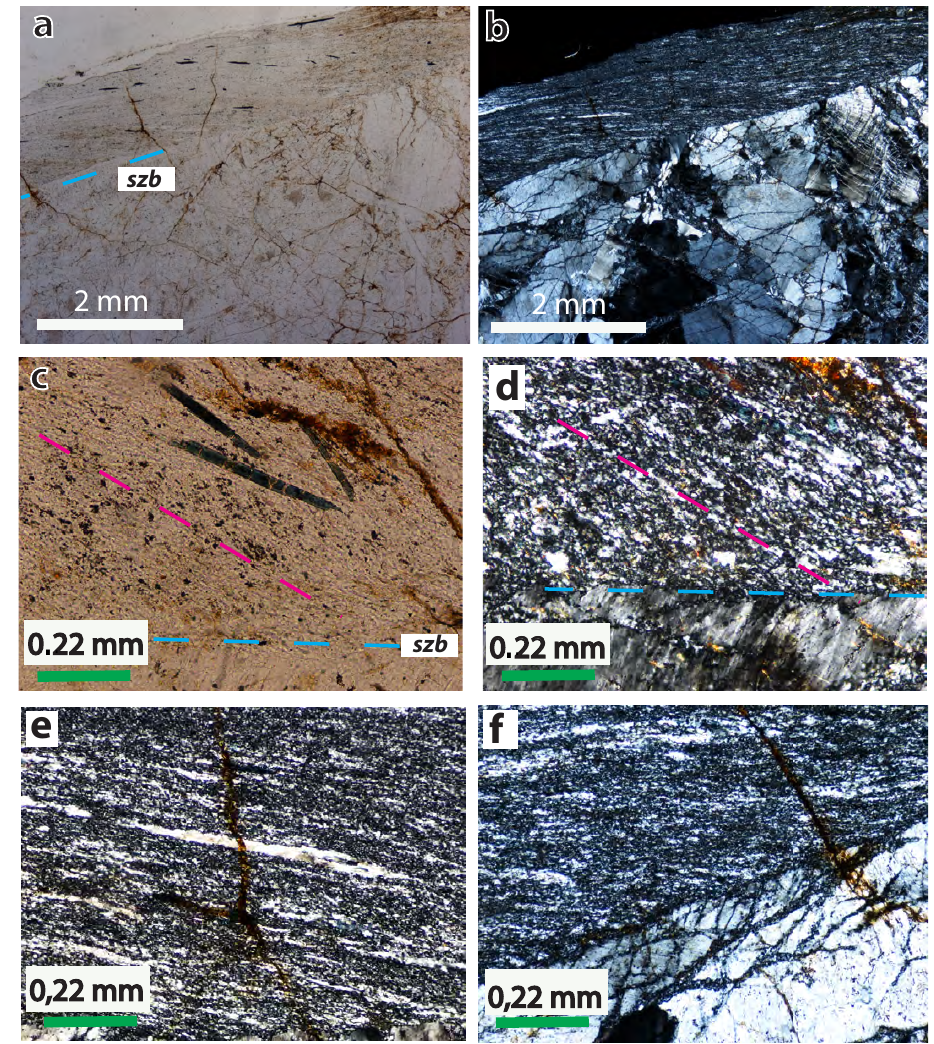
Figure 7. Microscopic view of ultramylonite. (a, b) Detail of ultramylonite and host protomylonite with the sharp shear zone boundary (szb) heritage of former host-fracture contact: (c) synkinematic Na amphibole, boudinaged within the quartz and albite ultramylonite matrix. Red dashed line (see also in d ) indicates the shape preferred orientation of the quartz and albite matrix, whereas in blue the shear zone boundary (szb) is indicated; (d) quartz and albite recrystallized matrix, in the lower part the boundary (blue dashed line) of microscale shear zone to a host quartz porphyroclast. (e) Quartz ribbon with a strong elongation (1 : 15, X/Z ratio) defining a shape preferred orientation oblique (15 ◦ ) to the shear zone boundary (see b for location of quartz ribbon within the shear zone). (f) Detail of shear zone boundary showing intragranular fractures in the host protomylonite showing Riedel geometry. Along the Riedel shear, former cataclastic fragments recrystallized to produce the fine (5–10µm in size) new